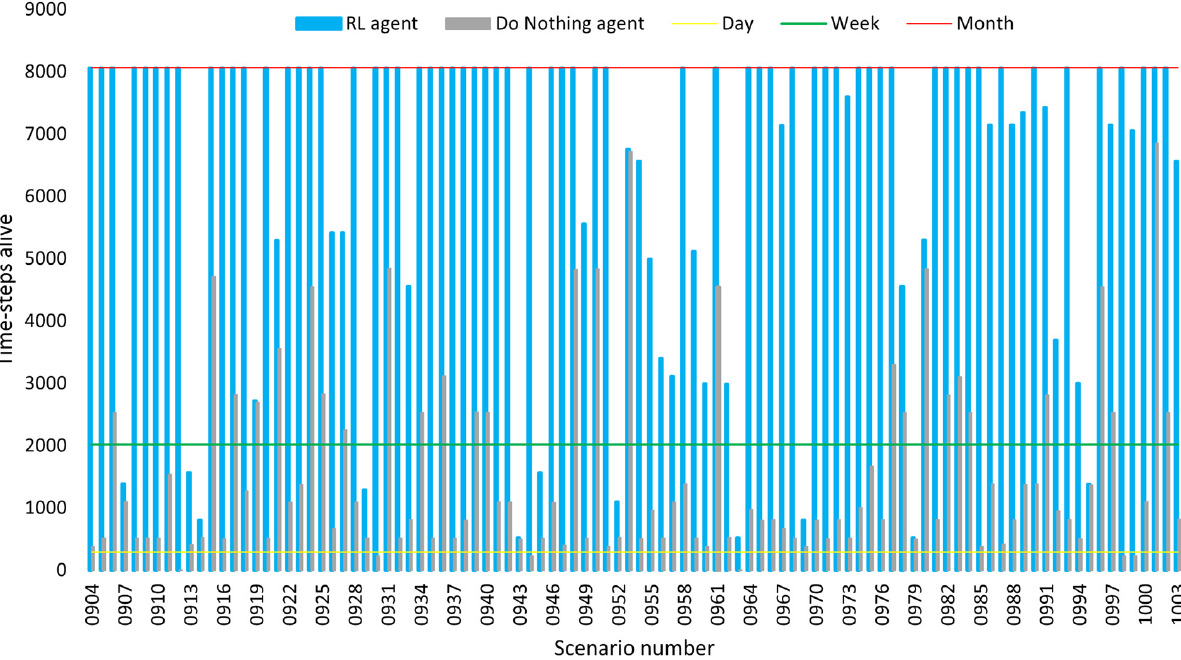
Figure 7. Training progress of the agent monitored by mean episode length for several observation spaces.